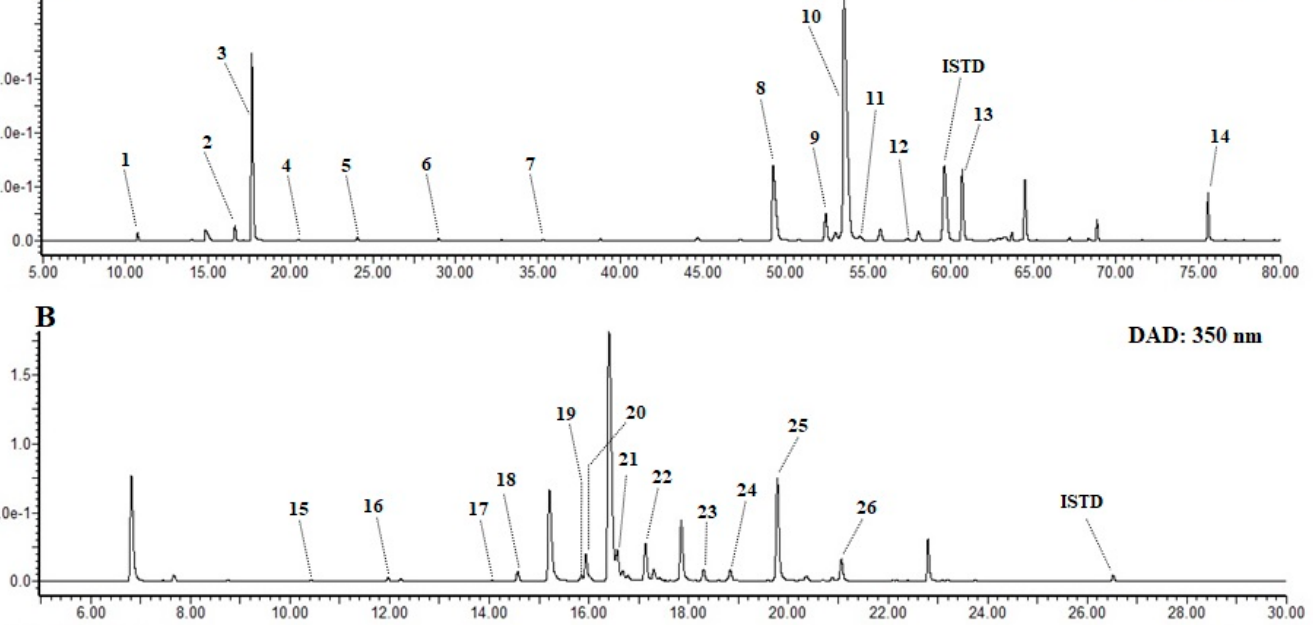
Figure 6. Ultra performance liquid chromatography coupled with diode array detector (UPLC-DAD) chromatograms of EPJ. ( A ) Phenolic acids at 320 nm, and ( B ) flavonoids at 350 nm. Compound names of each peak are presented in Table 1.